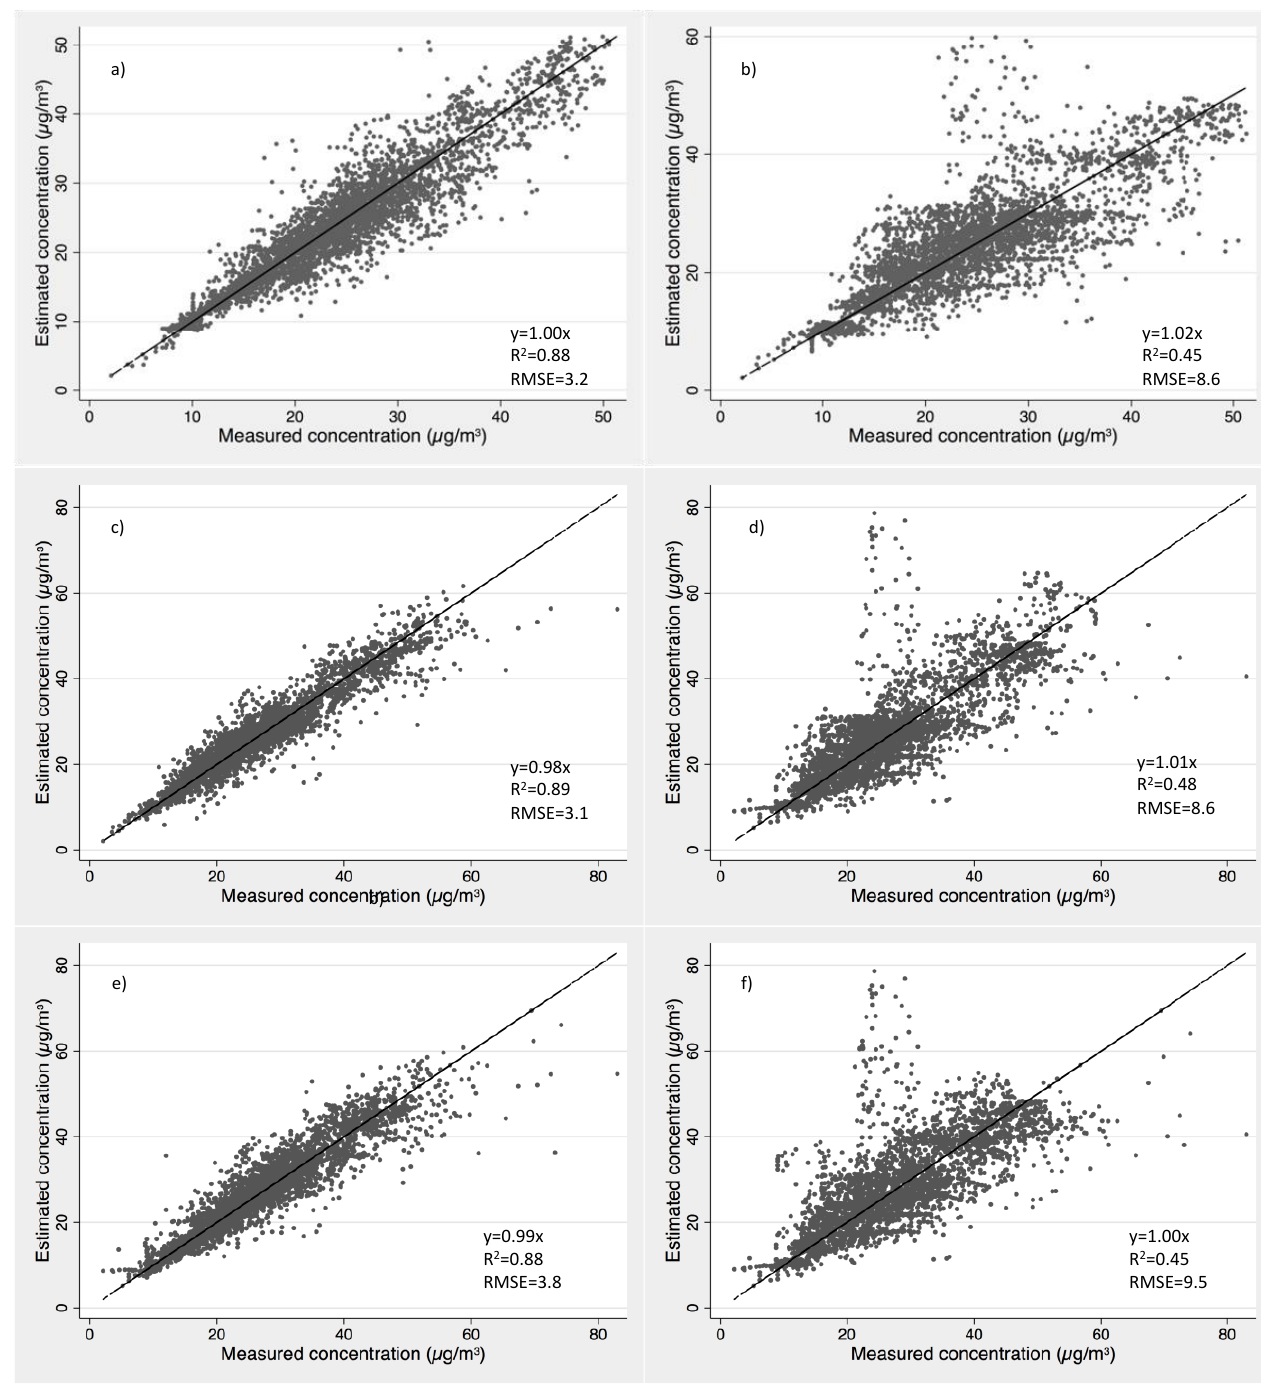
Figure 6. Predicted HCHO concentrations versus measured concentrations in selected houses using ( a ) emission rates predicted by the home-specific coefficients for each home using hourly averaged method, ( b ) corresponding constant emission rates by weekly average for each home using hourly averaged method, ( c ) emission rates predicted by the home-specific coefficients for each home using excluding outliner method, ( d ) corresponding constant emission rates by weekly average for each selected home using excluding outliner method, ( e ) emission rates predicted by the corresponding coefficients for each individual home using 8-hr average method, and ( f ) corresponding constant emission rates by weekly average for each selected home using 8-hr average method.